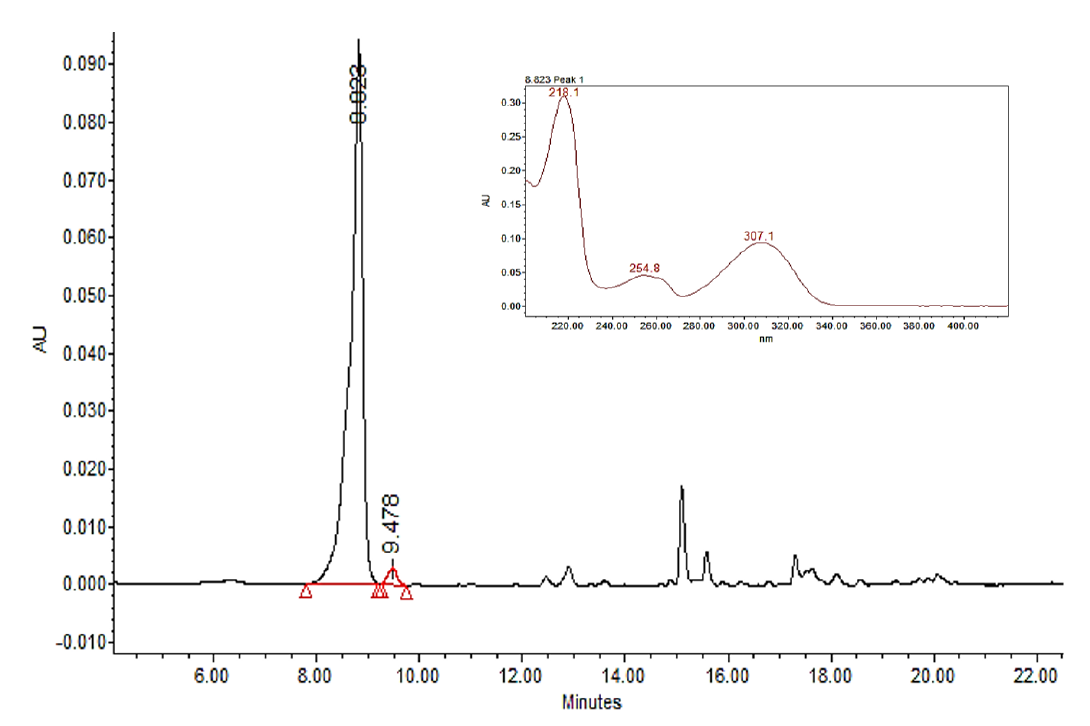
Figure 3. Comparison of ricinine in R. communis samples treated with different concentrations of SA.